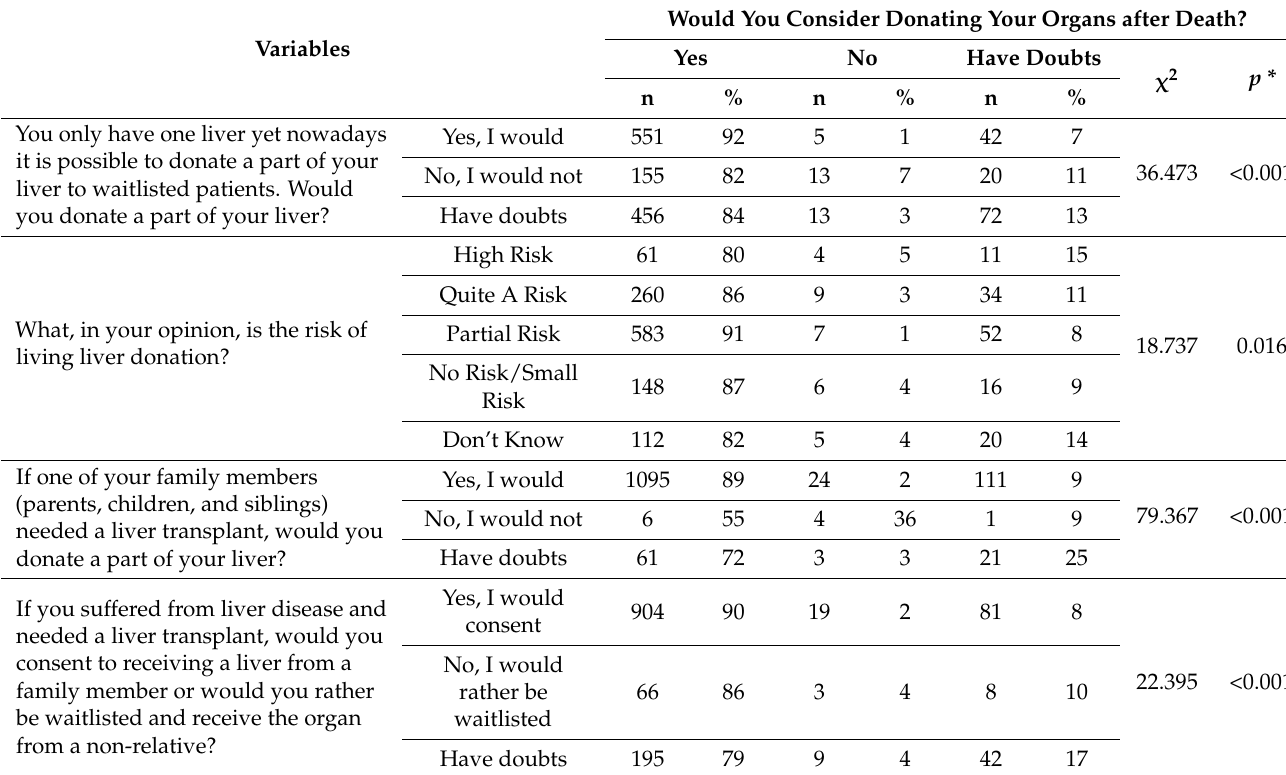
Table 6. The effect of selected variables on the answer to the question: “Would you consider donating your organs after